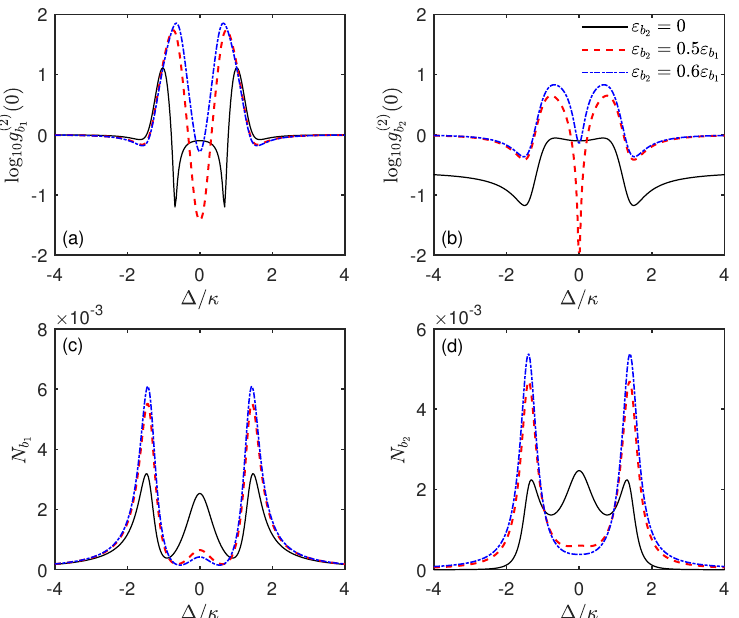
( 2 ) ( 0 ) and ( c , d ) the phonon b i